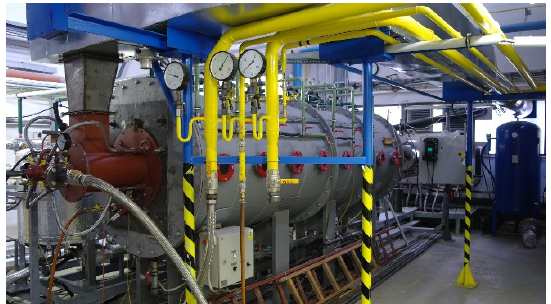
Figure 1. Semi-industrial burner testing facility. Table 1. Average natural gas composition during the combustion tests.